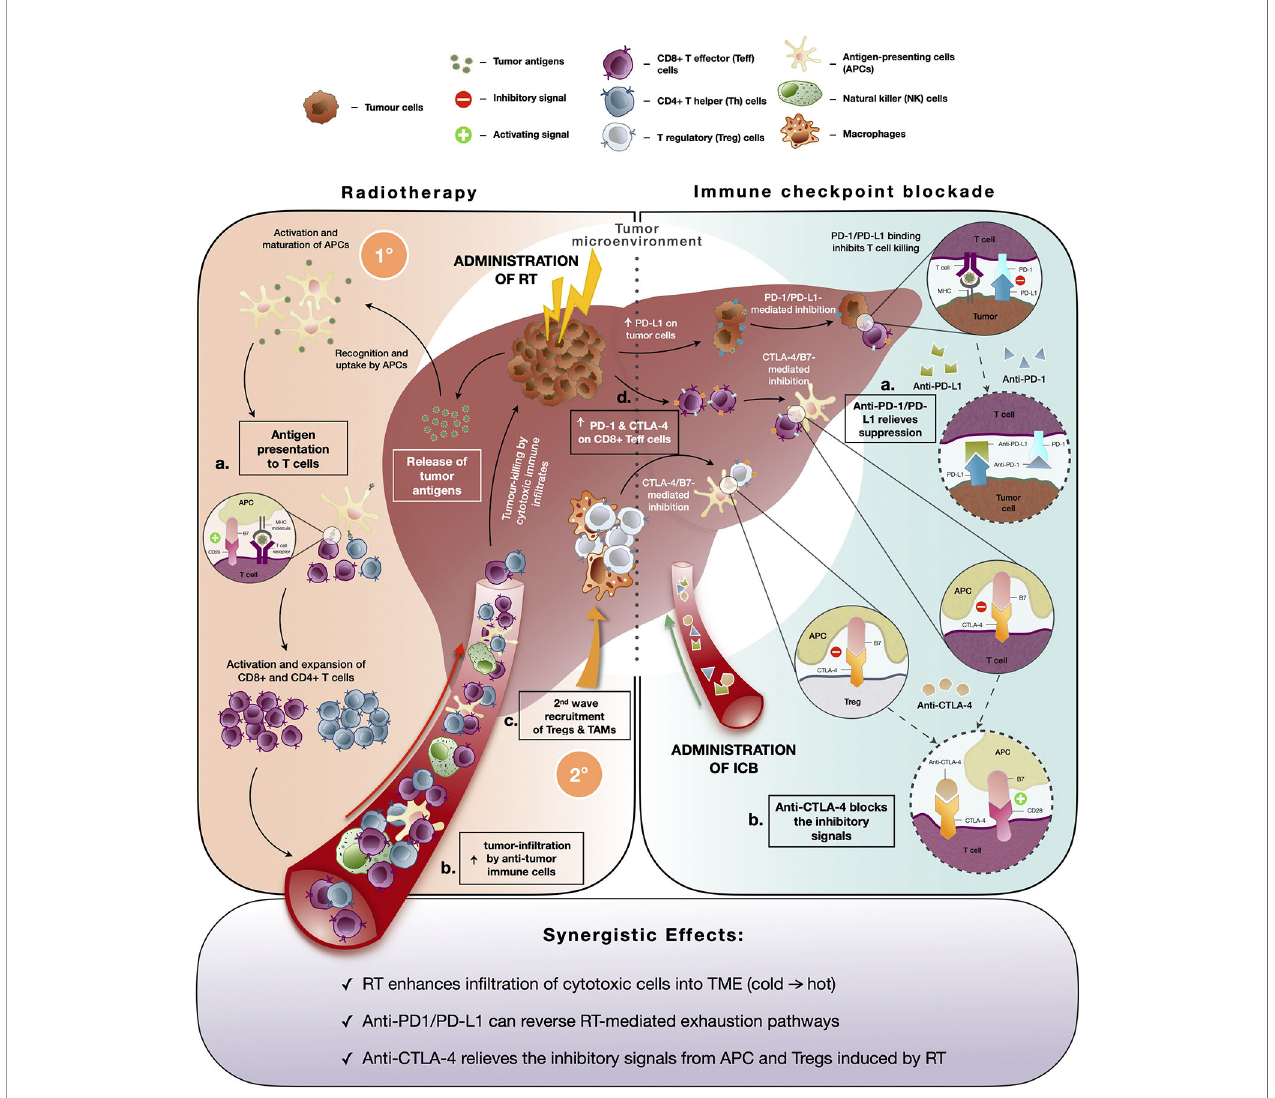
FIGURE 2 | Immune modifying effects of radiotherapy (RT) and immune-checkpoint blockade (ICB). (Left panel) Immune responses induced by radiotherapy (RT): Initial (1°C) anti-tumor immune response includes (A) increased pool of tumor antigens and DAMPs which results in antigen presentation activity, (B) subsequent activation of T cells and enhanced in fi ltration of anti-tumor immune cells into the TME to facilitate tumor-killing; Secondary (2°C) wave of immunosuppressive response is denoted by (C) recruitment of immunosuppressive immune subsets, Tregs and TAMs and (D) upregulated expression of immune checkpoint molecules by tumor cells (PD-L1) and cytotoxic CD8+ T cells (PD-1 and CTLA-4) which dampens anti-tumor activity. (Right panel) Immune responses mediated by immune checkpoint blockade (ICB): (A) Anti-PD-1 and anti-PD-L1 interferes with PD-1/PD-L1 interaction and relieves suppression of CD8+ T cells by tumor cells. (B) Anti- CTLA-4 blocks inhibitory signaling by inhibiting B7/CTLA-4 binding and allows for the activation of APCs and T cells. (Bottom panel) Potential synergistic effects of combining RT and ICB include enhanced in fi ltration of anti-tumor into TME post-RT and reversion of radiation-induced exhaustion and immunosuppression by